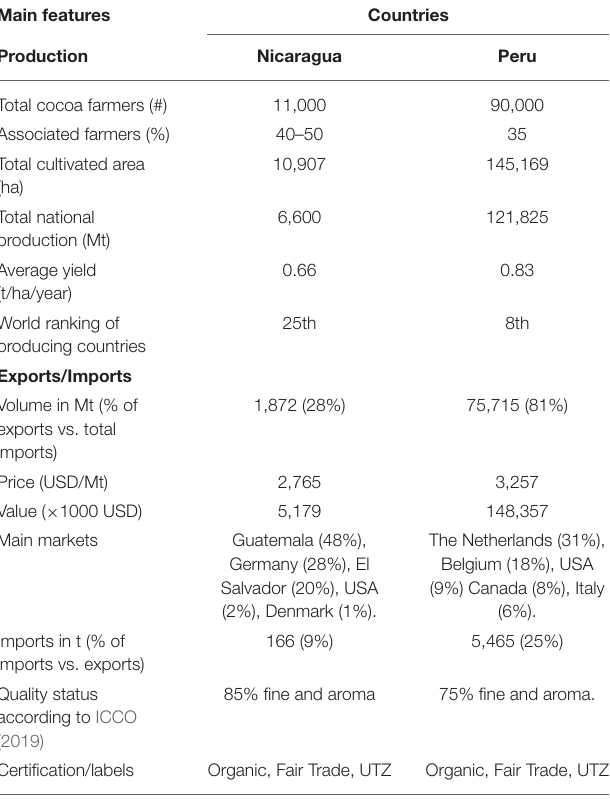
TABLE 1 | Number of farmers, cultivated area, production, average yield, imports, exports, certification labels and bean quality status of cocoa cultivation in Nicaragua and